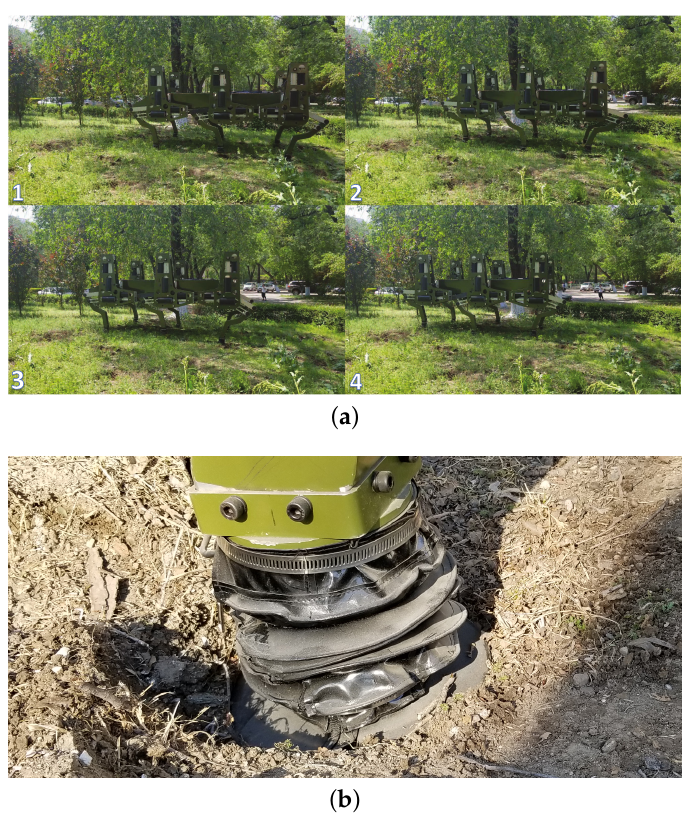
Figure 14. The snapshots of the natural soft terrain walking experiment: ( a ) the natural soft terrain walking process and ( b ) the foot sinkage caused by the deformation of the natural soft terrain.